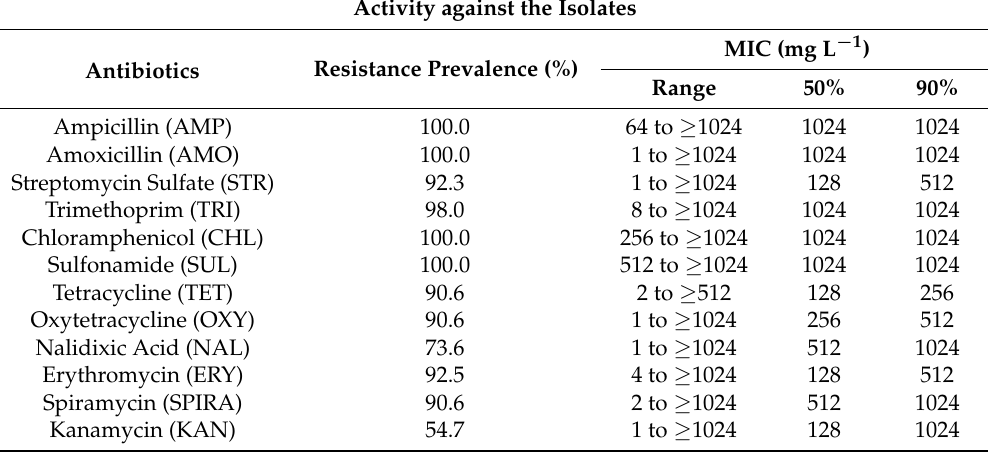
Table 4. Minimum inhibitory concentration (MIC) of 12 antibiotics against bacteria isolates obtained from WW, WTP and RW. Activity against the Isolates